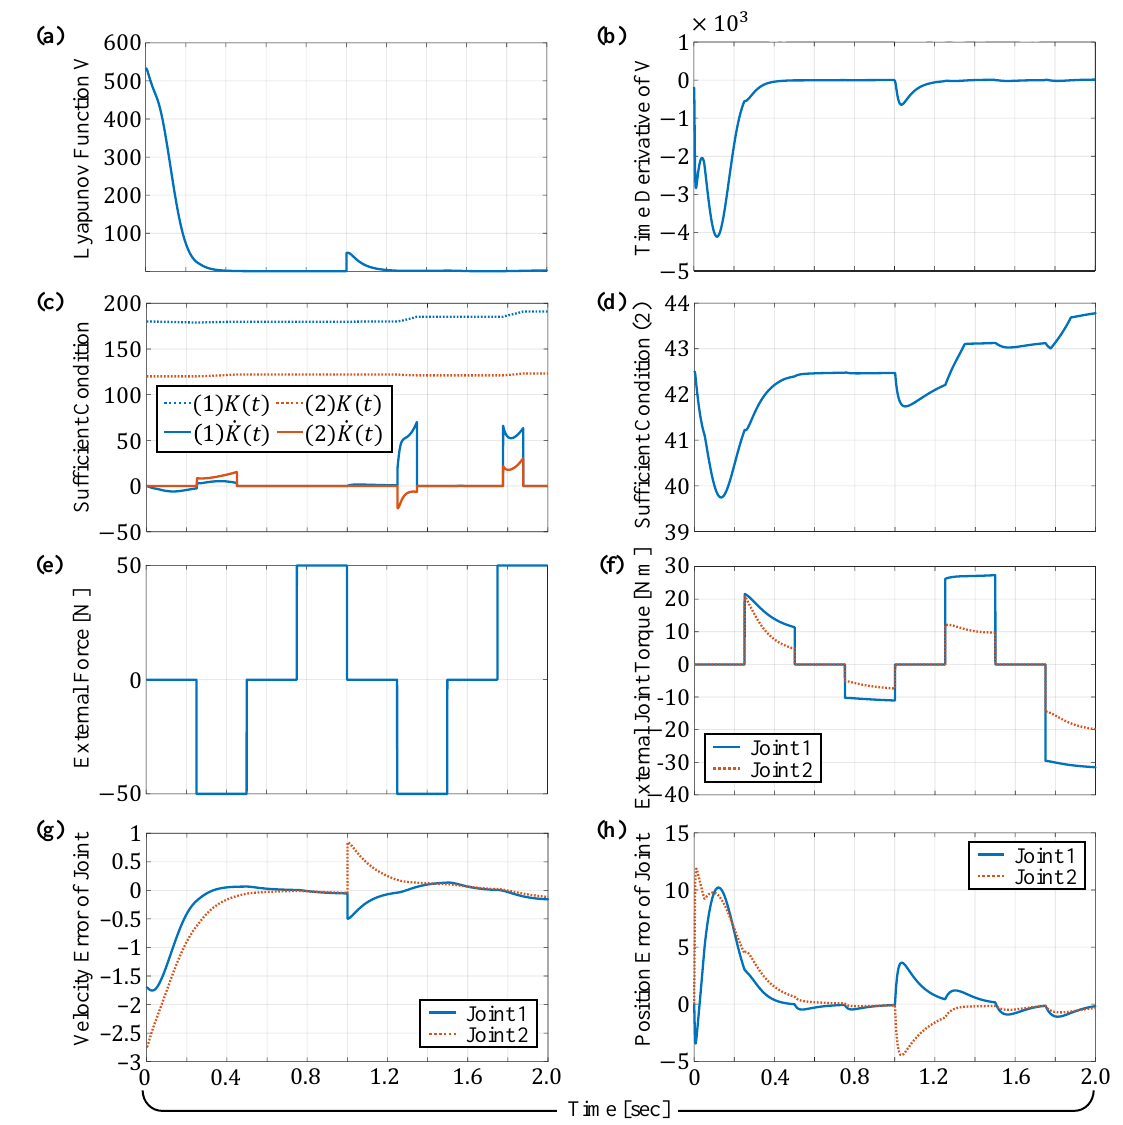
Figure 3. Simulation data while performing the simulation suggested in Figure 2; ( a ) Lyapunov function value of Equation (14) with α = 0.75, where it was designed using kinetic plus potential energies. ( b ) Time derivative of Lyapunov function of Equation (21), where we could confirm whether the closed-loop control system is being stable. ( c ) K ( t ) and ˙ K ( t ) were expressed with the proposed update rule Equation (26). We could confirm that the first sufficient condition of Equation (12) was satisfied. ( d ) Second sufficient condition, that is, where we could confirm that Equation (13) was satisfied even though the impedance parameters of K ( t ) and H ( q ) (its time derivative ˙ H ( q ) ) were changed according to the joint configuration. ( e ) External force f ext = 50 N applied to the x-axis, alternatively backward and forward with 0.25 s intervals. ( f ) External joint torques obtained by Equation (7). ( g ) Velocity error of the each joint. ( h ) Position error of each